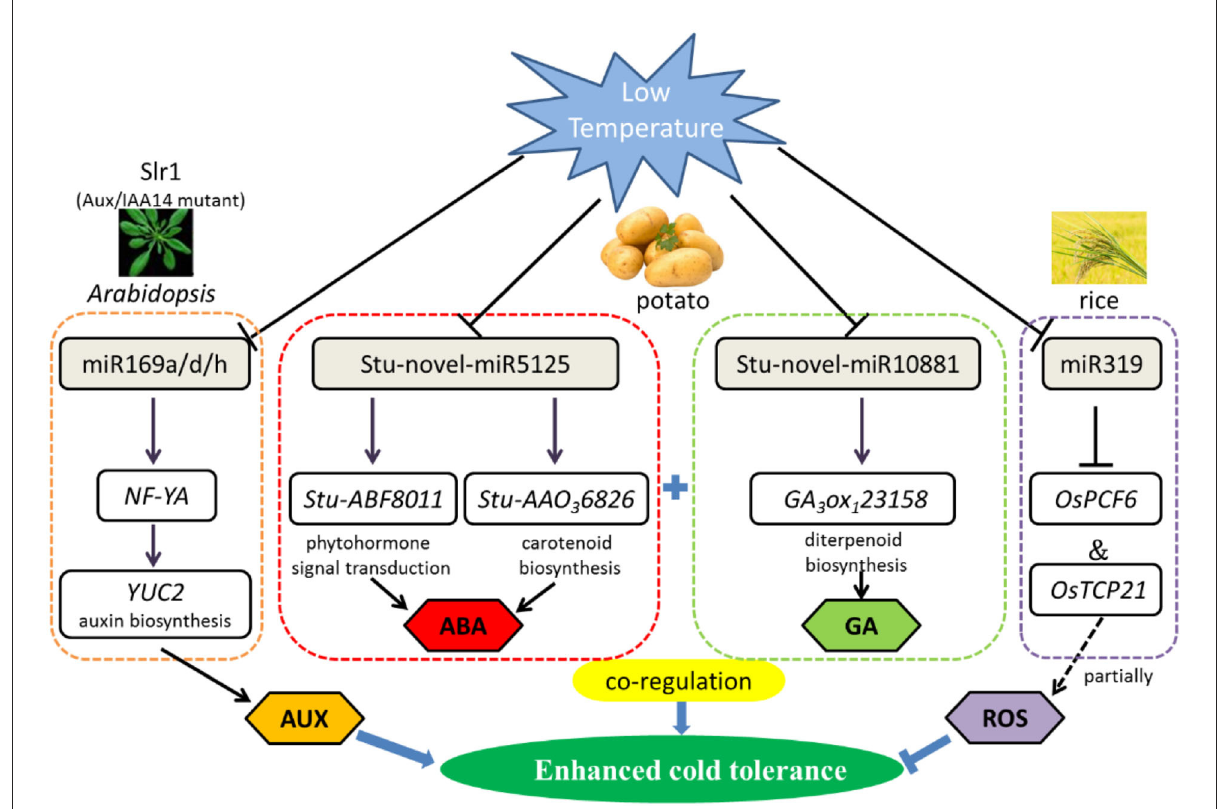
FIGURE1 Regulatory network of the miRNAs involved in low-temperature stress primarily by phytohormone signal transduction and ROS scavenging mechanism in plants. Cold stress-responsive miRNAs in Arabidopsis , potato, and rice are shown in the chart. The arrows and hammer represent positive and negative regulation, respectively. AUX/IAA, Auxin/indole acetic acid; NF-YA, nuclear factor Y subunit A; YUC2, flavin-binding monooxygenase family protein 2; ABF, auxin F-box protein; AAO, abscisic-aldehyde oxidase; TCP, teosinte branched (tb1)-cycloidea (CYC)-proliferating cell factors1 and 2 (PCF1 and PCF2) transcription factor; ABA, abscisic acid; GA, gibberellin; ROS, reactive oxygen